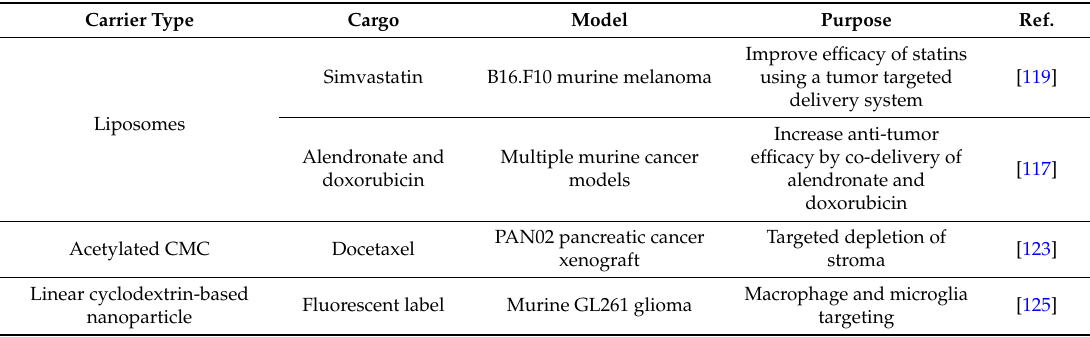
Table 1. Examples of studies using nanocarriers to passively target